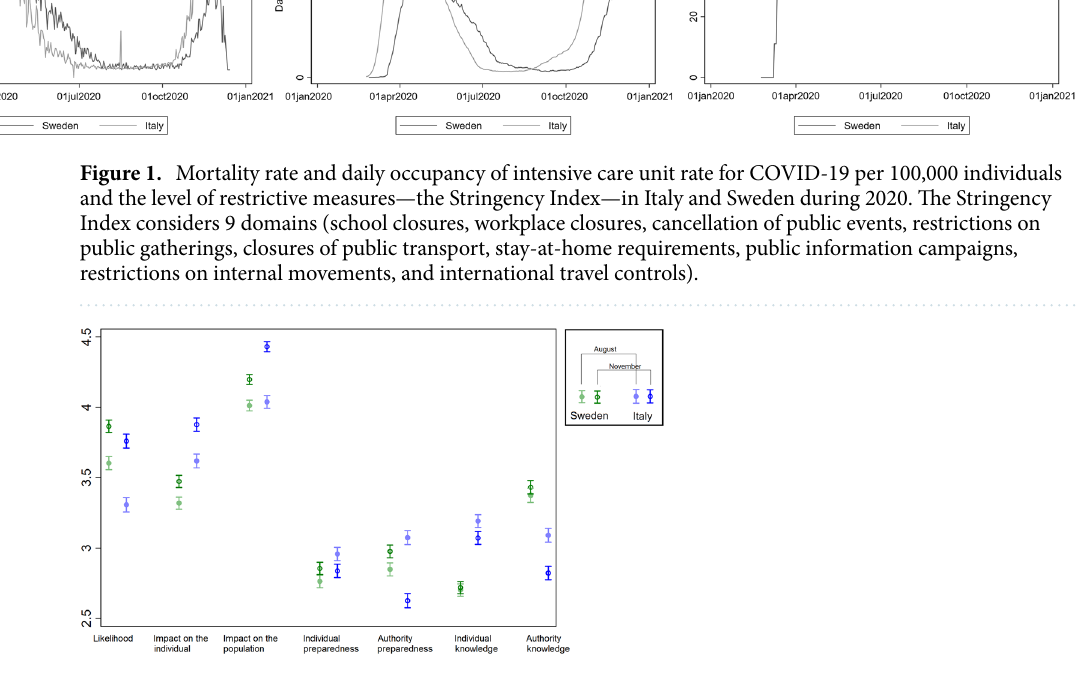
Figure 2. Means and 95% CIs for epidemic risk perception (likelihood, impact on the individual, impact on the population, individual preparedness, authority preparedness, individual knowledge, authority knowledge) by country and